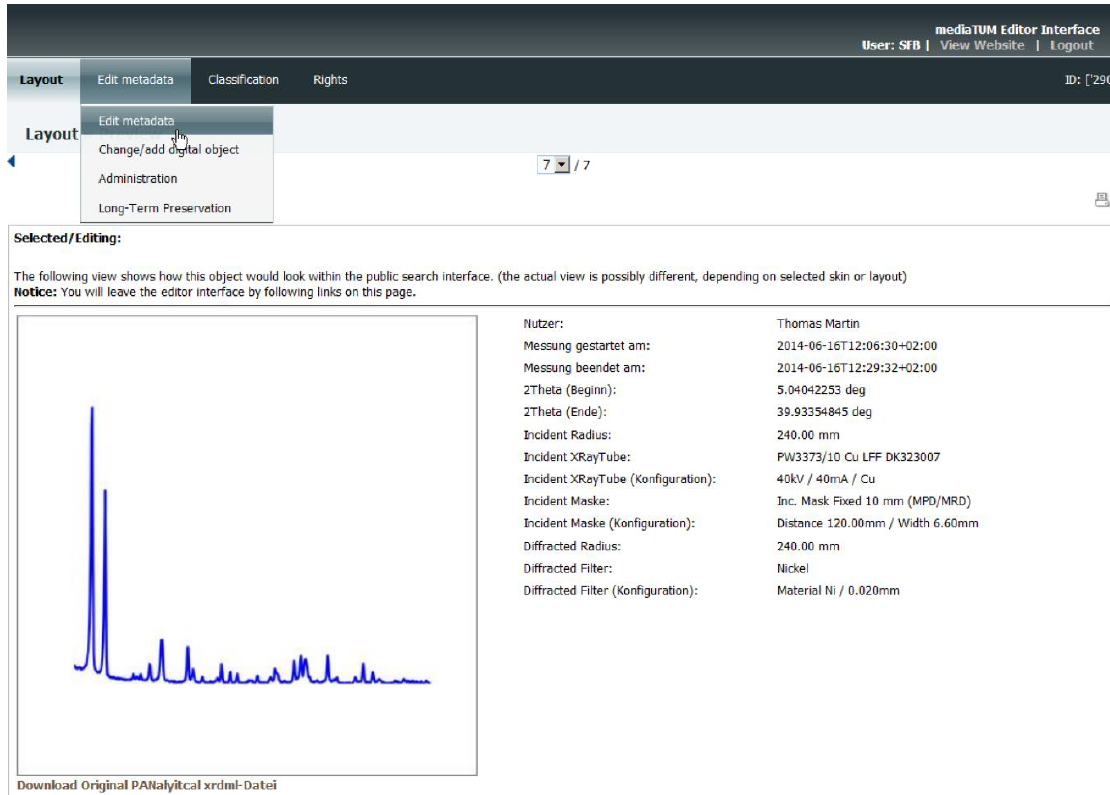
Figure 8. View and edit metadata in the data repository.